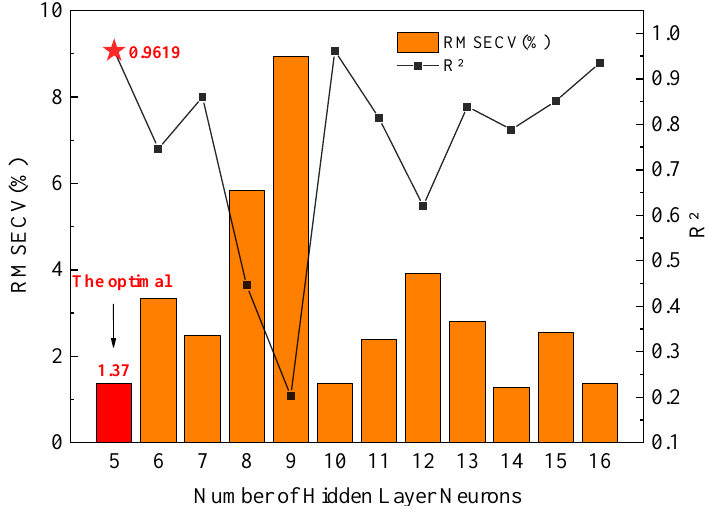
Figure 7. The RMSECV and R 2 values of PCA-ANN with different numbers of hidden layer neurons. Table 3. Quantitative analysis of the three chemometric